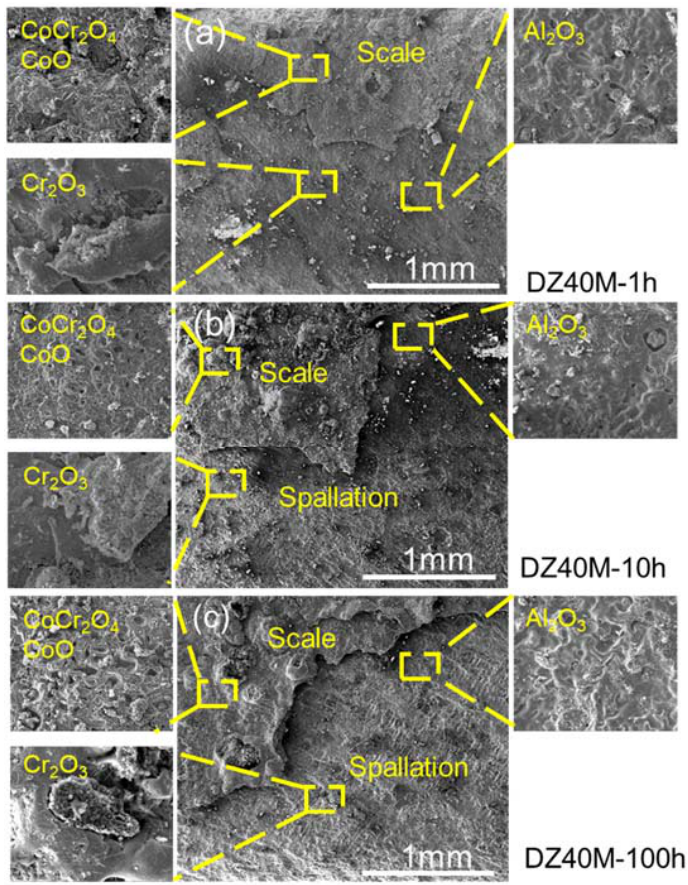
Figure 8. Surface morphology and composition of DZ40M after 1 h, 10 h, and 100 h of continuous hot corrosion. ( a ) 1 h, ( b ) 10 h, and ( c ) 100 h.